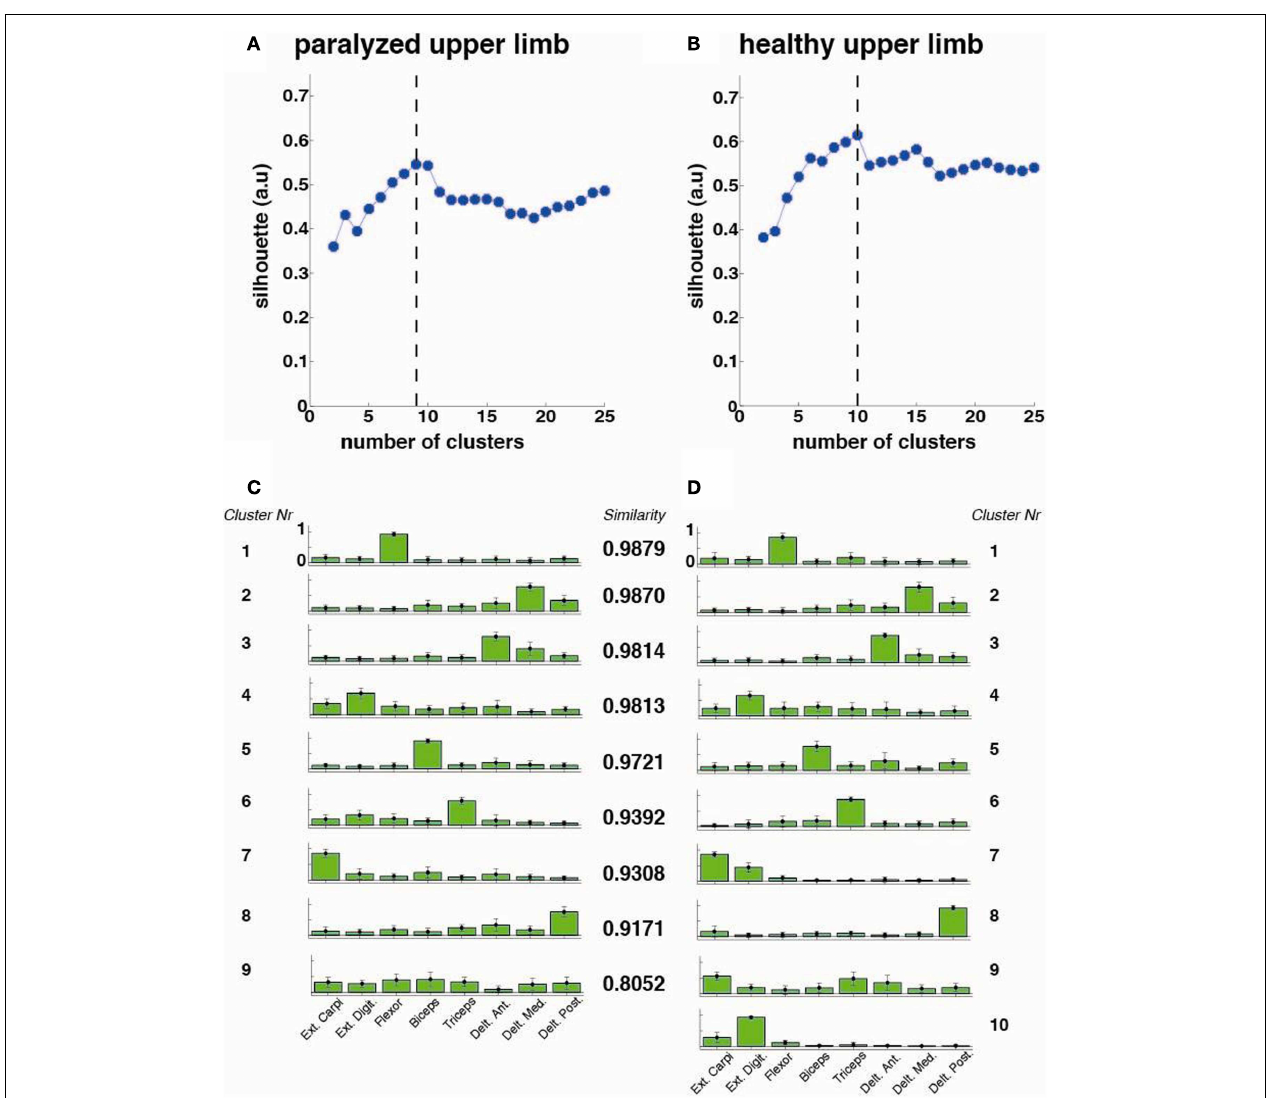
(3) flexor carpi radialis, palmaris longus, flexor carpi ulnaris (flexor), (4) long head of the biceps, (5) the external head of the triceps, (6) anterior portion of deltoid muscle (Delt. Ant.), (7) lateral portion of deltoid muscle (Delt. Lat.), and (8) posterior portion of deltoid over the teres minor and infraspinatus muscles (Delt. Post).The similarity between synergies (clusters) from the healthy and paralyzed upper limb was measured by the scalar product (a similarity value of 1 means perfect match between